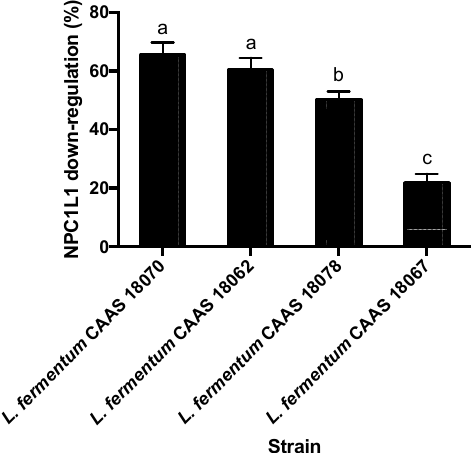
Figure 2. Comparison of lactic acid bacterial strains for NPC1L1 down-regulation ability. Data are represented as the mean ± SD ( n = 3). Means not sharing a common letter differ significantly from each other ( p < 0.05).